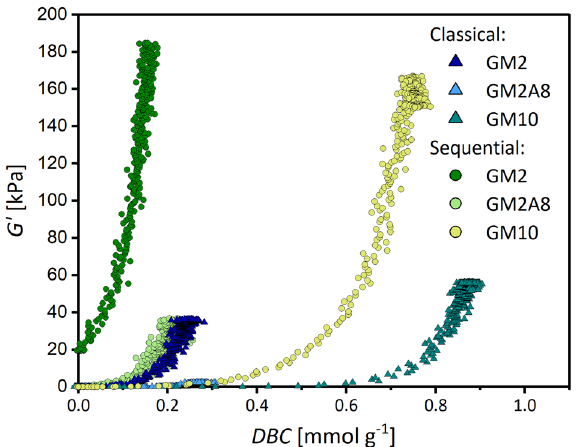
Figure 5. Increase of storage modulus G ′ with the double bond conversion ( DBC ) for the three gelatin derivatives GM2, GM2A8, and GM10 using the classical or the sequential cross-linking procedure, respectively. Note that the light blue triangles representing the data obtained for GM2A8 with the classical cross-linking procedure are visible close to the abscissa at DBC s below 0.3 mmol g −1 . The figure was created with Origin